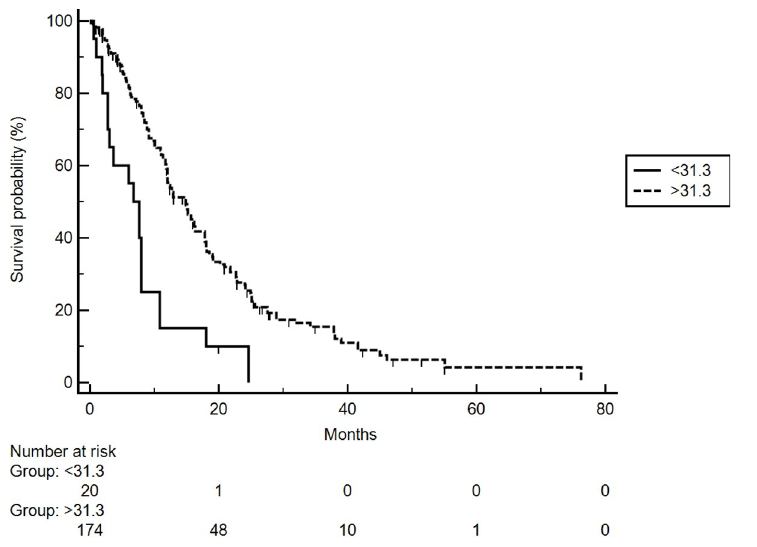
Fig 1. OS according to PNI (high- vs low-group) in the training